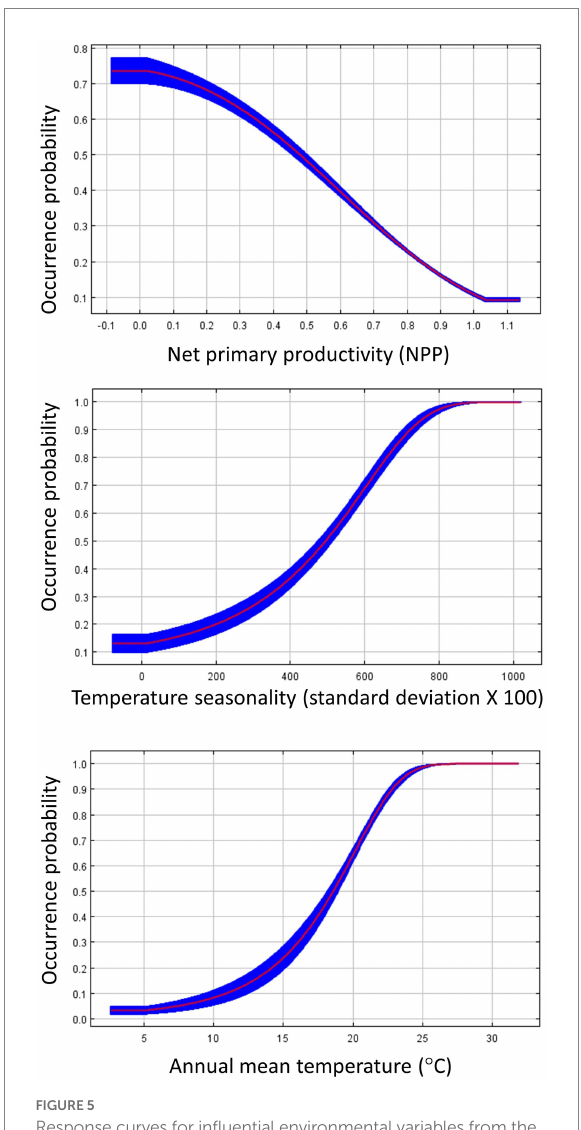
FIGURE 5 Response curves for influential environmental variables from the species distribution model predicting Dickcissel occurrence during fall migration. The response curves were generated in Maxent, and show how the predicted occurrence probability changes with each variable, while keeping all other variables at their average sample value. The red line plots the average value of the five model replicates, and the blue area plots the variance among the five